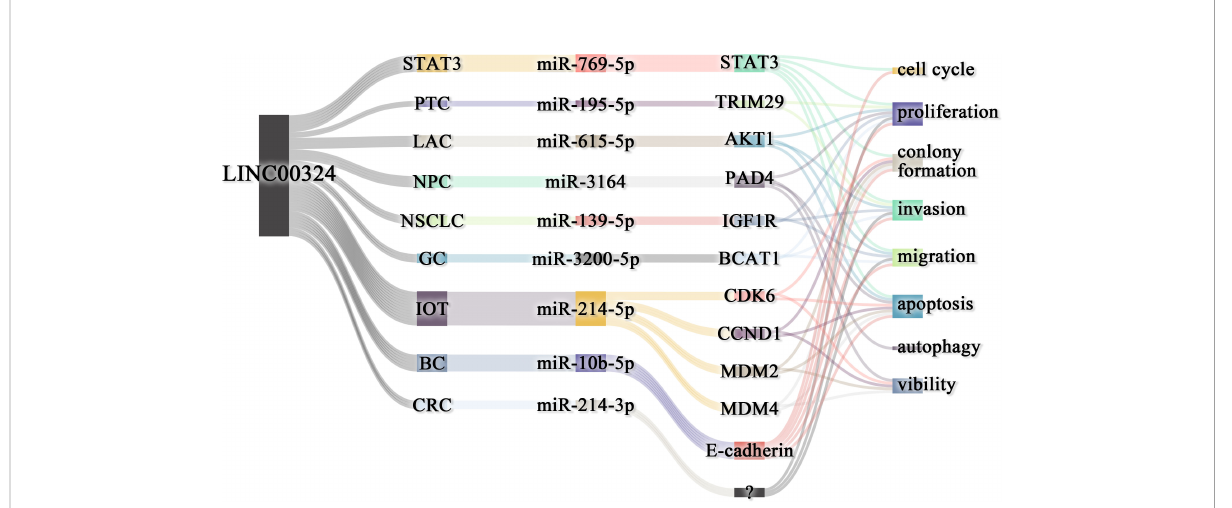
FIGURE 6 LINC00324 regulates cancer phenotype through ceRNA axes. BC, Breast cancer; CRC, Colorectal cancer; GC, Gastric cancer; LAC, Lung adenocarcinoma; NPC, Nasopharyngeal carcinoma; NSCLC, Non-small cell lung carcinoma; PTC, Papillary thyroid cancer; RB,